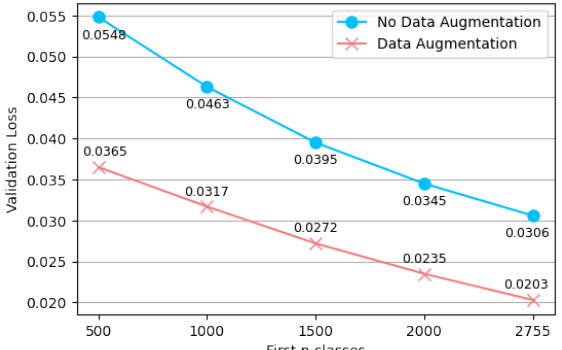
Figure 9. Validation loss in different data sets and data augmentation. The x-axis is the number of sample classes in the training dataset, i.e., first 500, 1000, 1500, 2000, 2755 classes. The y-axis is the MSE loss on last 1000